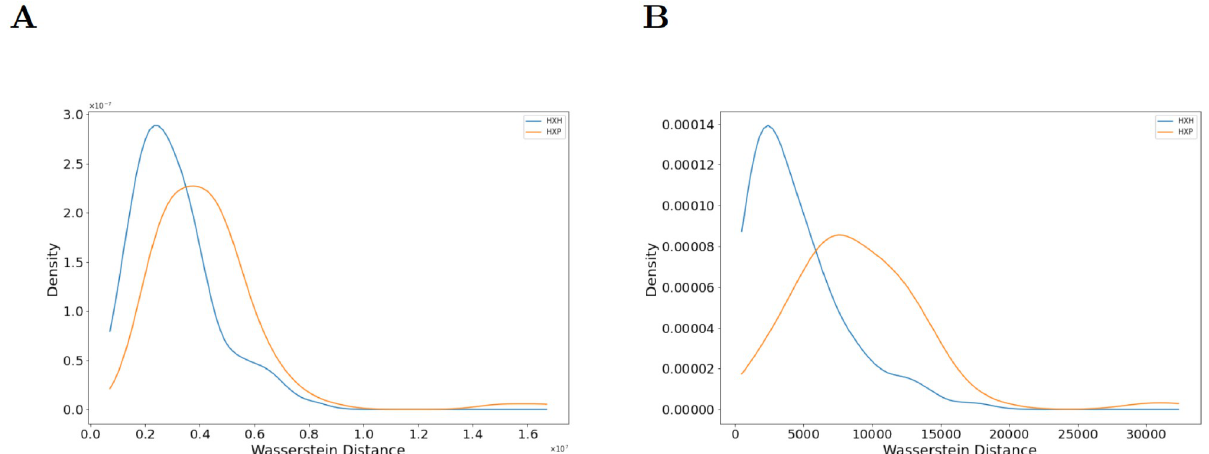
Fig 7. Distributions of Wasserstein distances between persistence diagrams for B cells. (A) Distributions of Wasserstein distance between H 0 - persistence diagrams for H × H (blue line) and H × P (orange line) pairs (p = 6.28 × 10 − 5 , QFD = 0.0300). (B) Distributions of Wasserstein distance between H 1 -persistence diagrams for H × H (blue line) and H × P (orange line) for the same pairs in (A) (p = 1.07 × 10 − 12 , QFD = 0.0946). Persistence diagrams are calculated from point clouds in the CXCR5, PD-1, and TCF-1 axes. p-values are calculated from a 2-sided KS test.